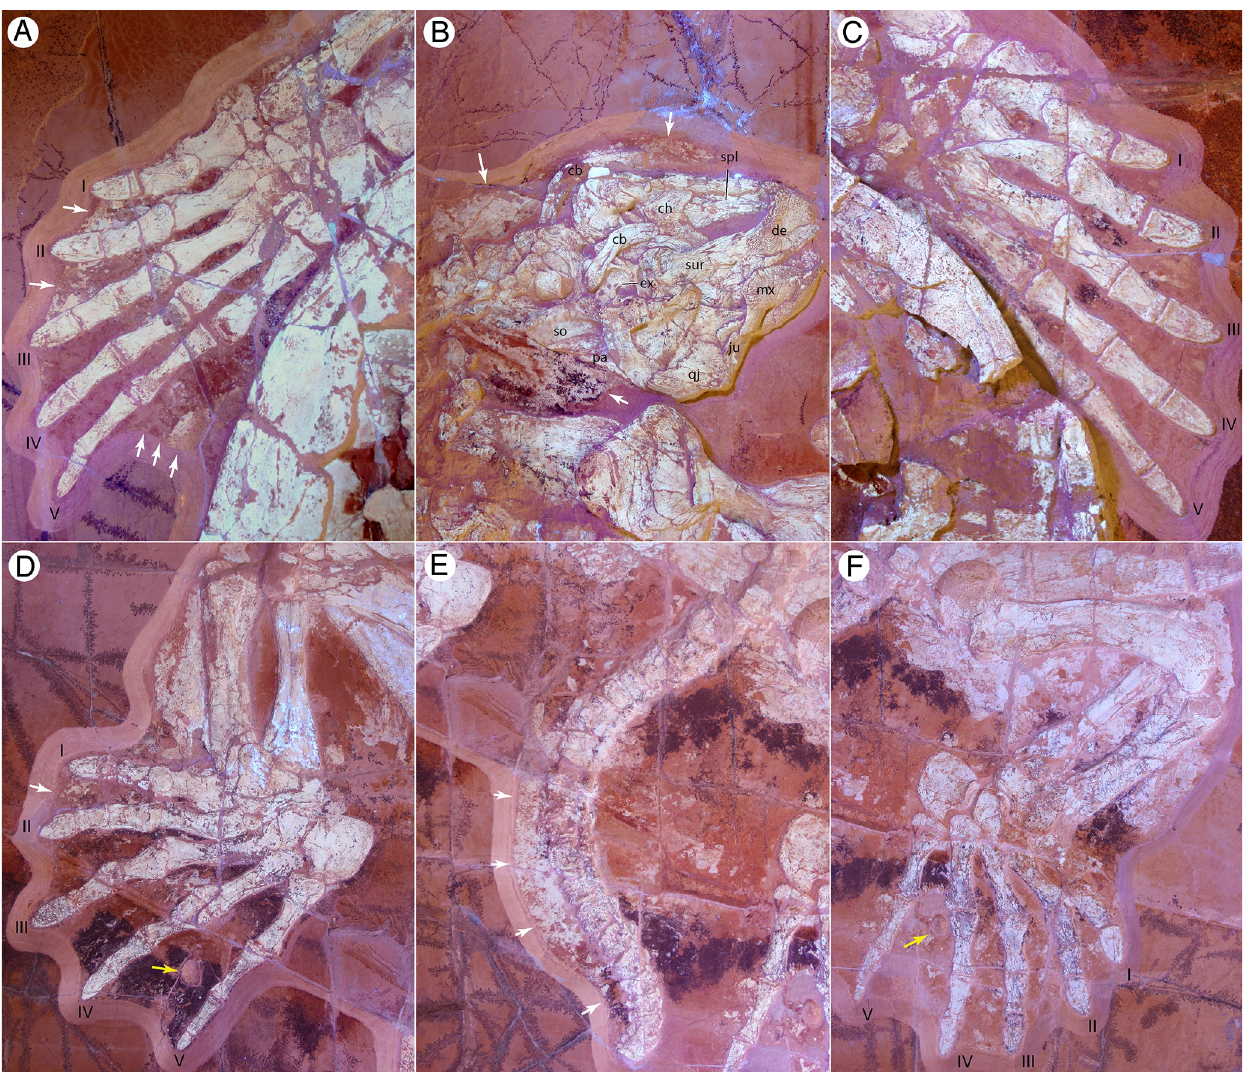
Fig 3. NKMB Watt18/211, Thalassemys bruntrutana , Late Jurassic (late Kimmeridgian) of Wattendorf, Bavaria, Germany. Photographs taken under UV light. (A) right forelimb, (B) skull and neck, (C) left forelimb, (D) right hind limb, (E) tail, and (G) left hind limb in ventral view. White arrows highlight soft tissue. Yellow arrows indicate epibionts. For anatomical interpretation of vertebral column and limb, please refer to Fig 2. Abbreviations: cb, ceratobranchial; ch, ceratohyal; de, dentary; ex, exoccipital; ju, jugal; mx, maxilla; pa, parietal; qj, quadratojugal; so, supraoccipital; sur, surangular.